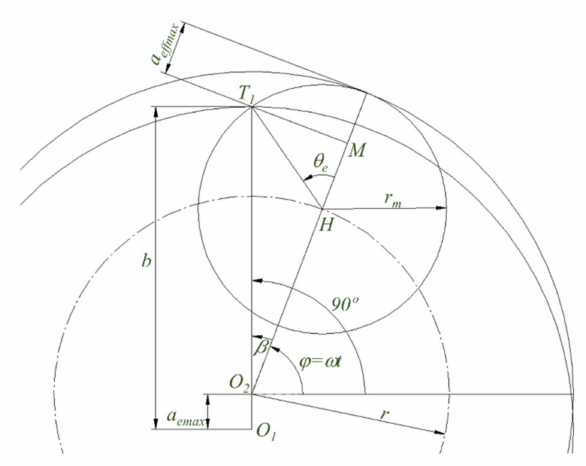
Figure 6. Trochoidal path approximation.